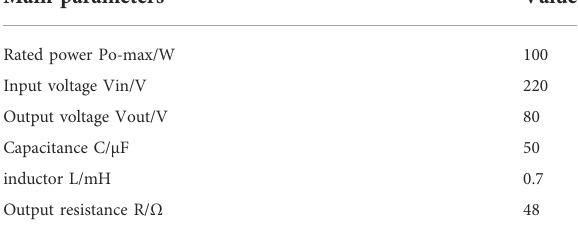
TABLE 2 Main parameters of the Buck converter with rated power of